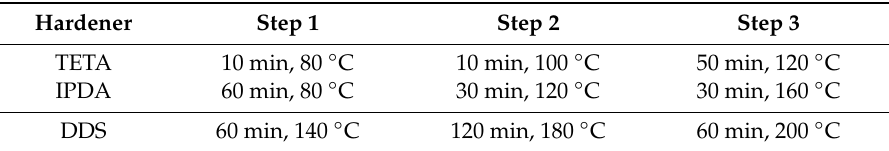
Table 2. Curing cycle for produced laminates.